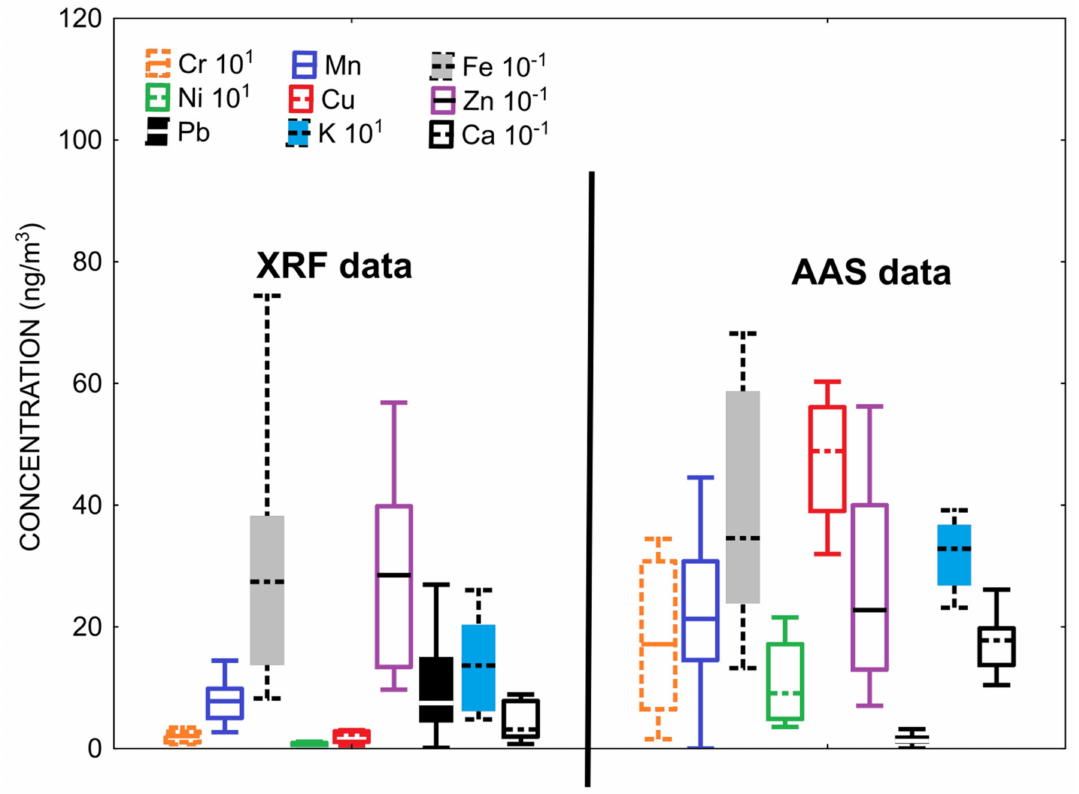
Figure 5. Data for PM10-bound elements for spring period. Boxes show the range between the 25th and 75th percentiles. The whiskers extend from the edge of the box to the 5th and 95th percentiles of data. The horizontal line inside indicates the median